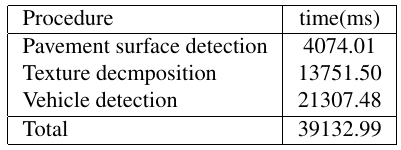
Table 1: Computation time of each procedure. The computation time is obtained with a PC of an Intel 2.4GHz